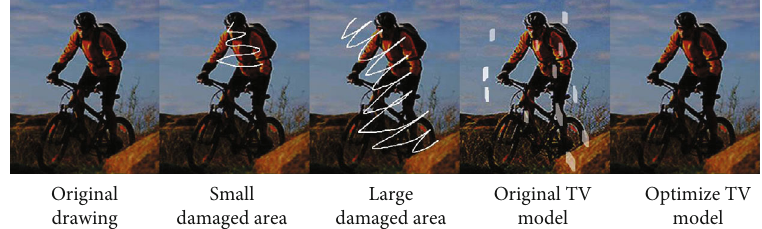
Figure 10: Comparison e ff ect between original TV repair model and optimized TV repair